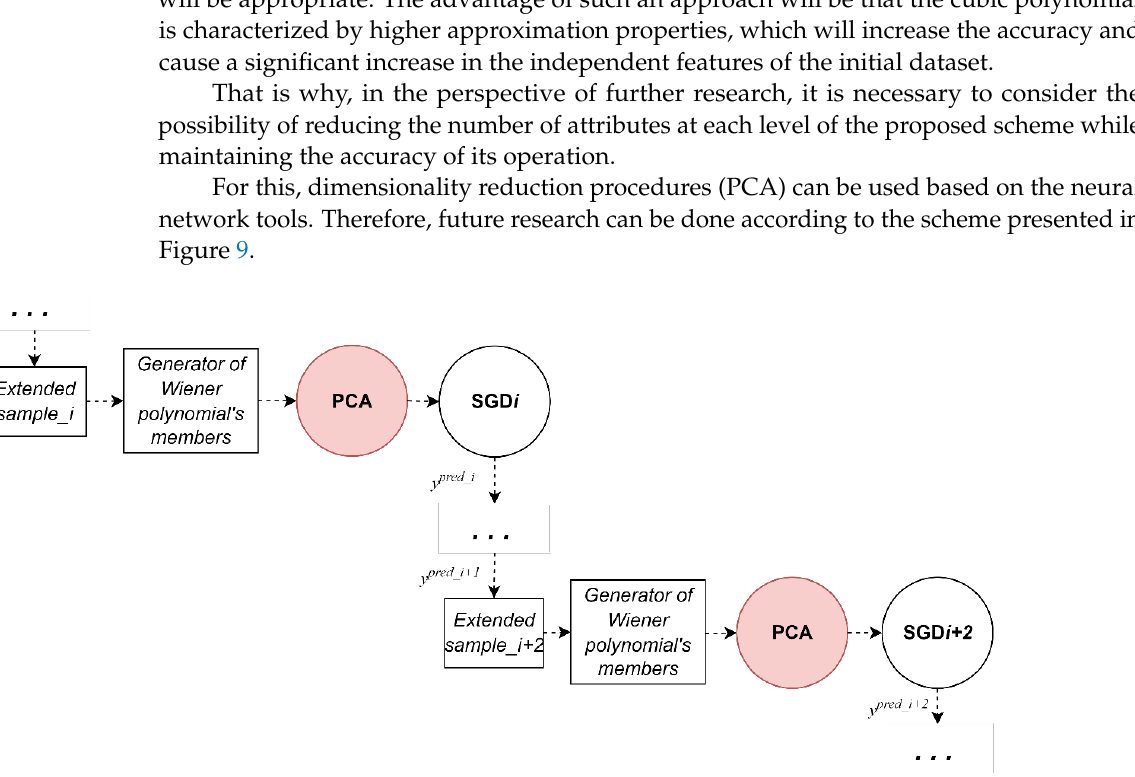
Figure 9. Future-research ensemble scheme using dimensionality reduction blocks at each level. In particular, using dimensionality reduction blocks (PCA) at each level of the en- semble scheme will allow one to control the number of independent features before ap- plying them to the selected regressor. It will significantly reduce the training time of the latter. This approach will improve the effectiveness of using the developed ensemble scheme in the case of many independent attributes of the initial dataset, which a signifi- cantly non-linear response surface will characterize. In addition, among the prospects for further research, it would be good to consider other options for the non-linear expansion of the inputs, as well as the use of different methods as a basic regressor or classifier at each level of the developed ensemble scheme. 5. Conclusions This paper solved the problem of approximating large datasets in the biomedical en- gineering area using a machine learning approach. Since single machine learning methods do not provide a sufficient approximation accuracy and high generalization, the authors consider the class of ensemble machine learning. The paper outlines the shortcomings of three main groups of ensemble machine learning methods in the case of the analysis of large datasets. Among them are the high complexity of training procedures, the large com- puting resources for its implementation, and a considerable duration of its work. Previous studies [33] demonstrate the high efficiency of approximating non-linear dependencies by the Wiener polynomial. The high-speed implementation of machine learning procedures to implement this approach is based on one of the fastest machine learning methods, SGD. However, increasing the approximation accuracy requires ex- panding the order of this polynomial, which causes a significant increase in the number of independent features for analysis. This, in turn, leads to an increase in the duration of the training procedures, which is critical when analyzing large datasets. In addition, this approach can provoke an overfitting of the selected machine learning method. In order to eliminate these shortcomings, the authors developed a new ensemble structure that combines both of the above instruments but avoids the drawbacks of their work. The procedures of its training and application are described and illustrated in de- tail. The cascade scheme allows for a high-order approximation of the Wiener polynomial without significantly increasing the number of independent features in the dataset. The modeling was carried out using a real-world dataset of a large volume. The pa- per presents several results of the experimental studies on selecting the optimal parame-